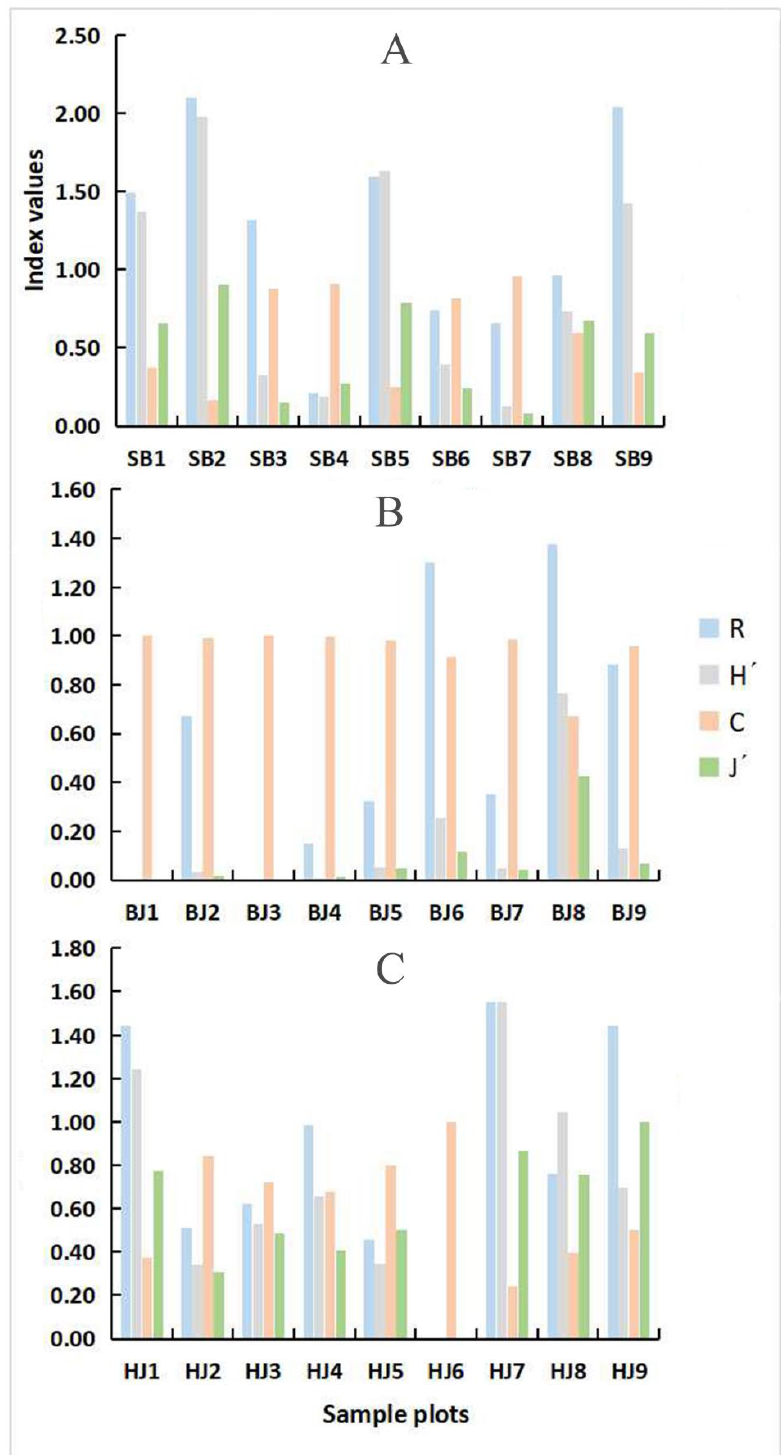
Figure 7. Community diversity of Erythroneurine leafhoppers in each sample plot (( A ): Shibing; ( B ): Bijie; ( C ): Huajiang). R , Margalef Species richness index; H’ , Shannon-Wiener Diversity index; C , Simpson Dominance index; J’ , Pieluo Uniformity index.